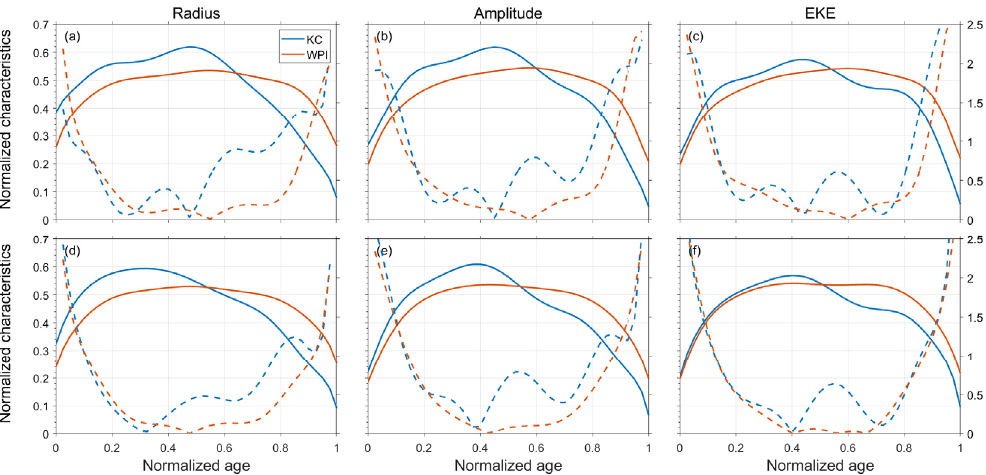
Figure 6. Time evolution of mean eddy characteristic parameters (solid curves, normalized by their range) and the absolute values of their time derivative (dashed curves): ( a , d ) radius, ( b , e ) amplitude, and the EKE ( c , f ). The blue curve in each panel represents the characteristics of eddies that reach the Kuroshio region (KC), whereas the red curve represents those in the western Pacific interior (WPI). Upper panels show cyclonic eddies, and lower panels show anticyclonic eddies.